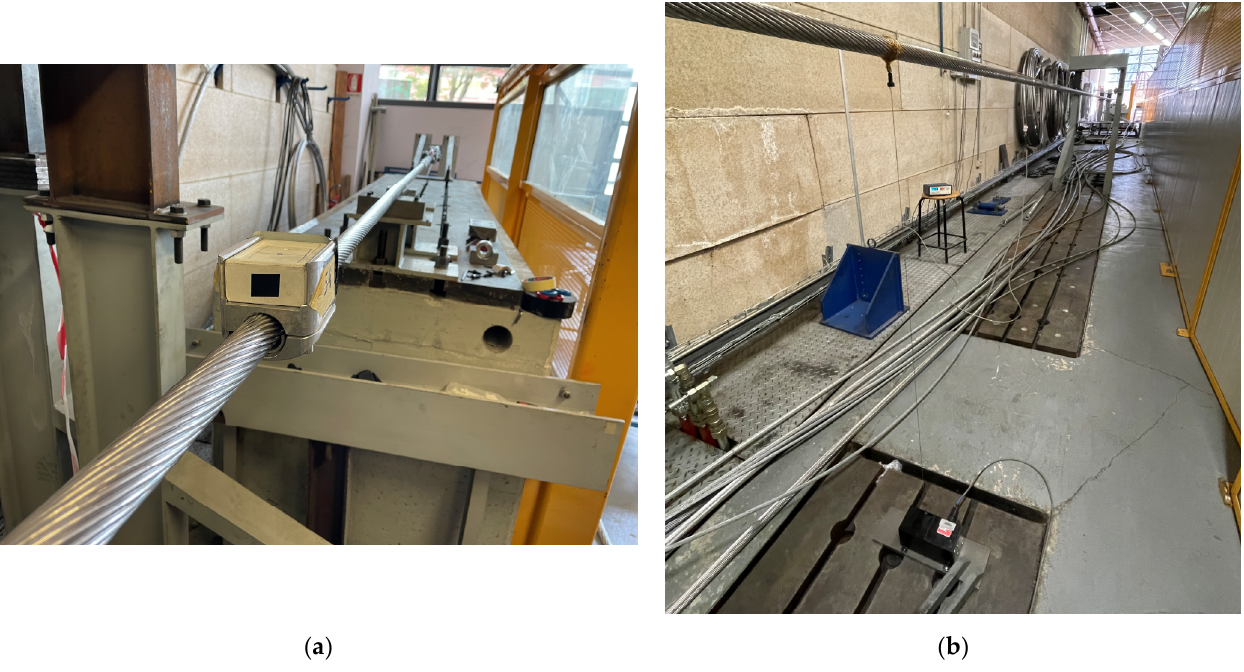
Figure 4. Experimental set-up arranged in the Cable Dynamics Laboratory: ( a ) Sensor node positioned at one extremity to carry out angular measurement; ( b ) Linear position sensor placed at midspan to obtain the reference value of maximum sag.